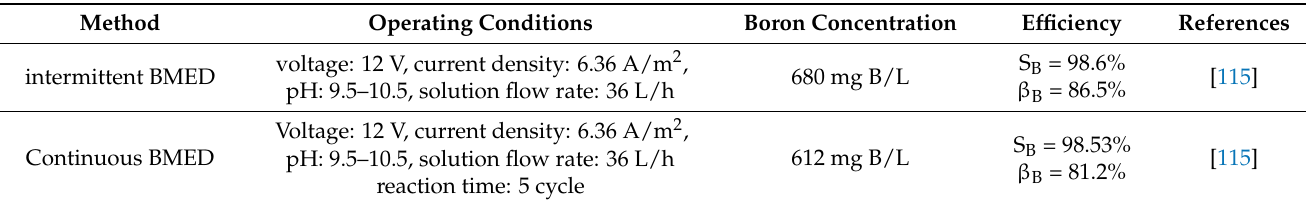
Table 2. Separation and recovery of boron from aqueous solutions using BMED.